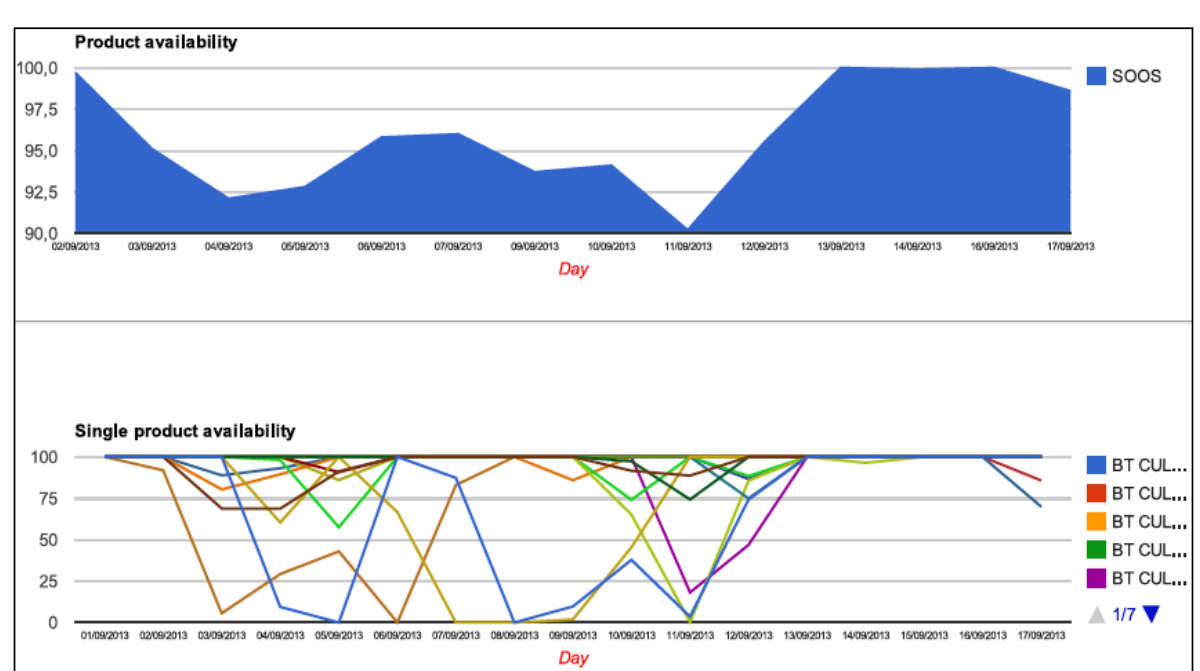
Figure 17. An example of OOS report with respect to average product availability (on shelf) and single SKU availability during the scalability